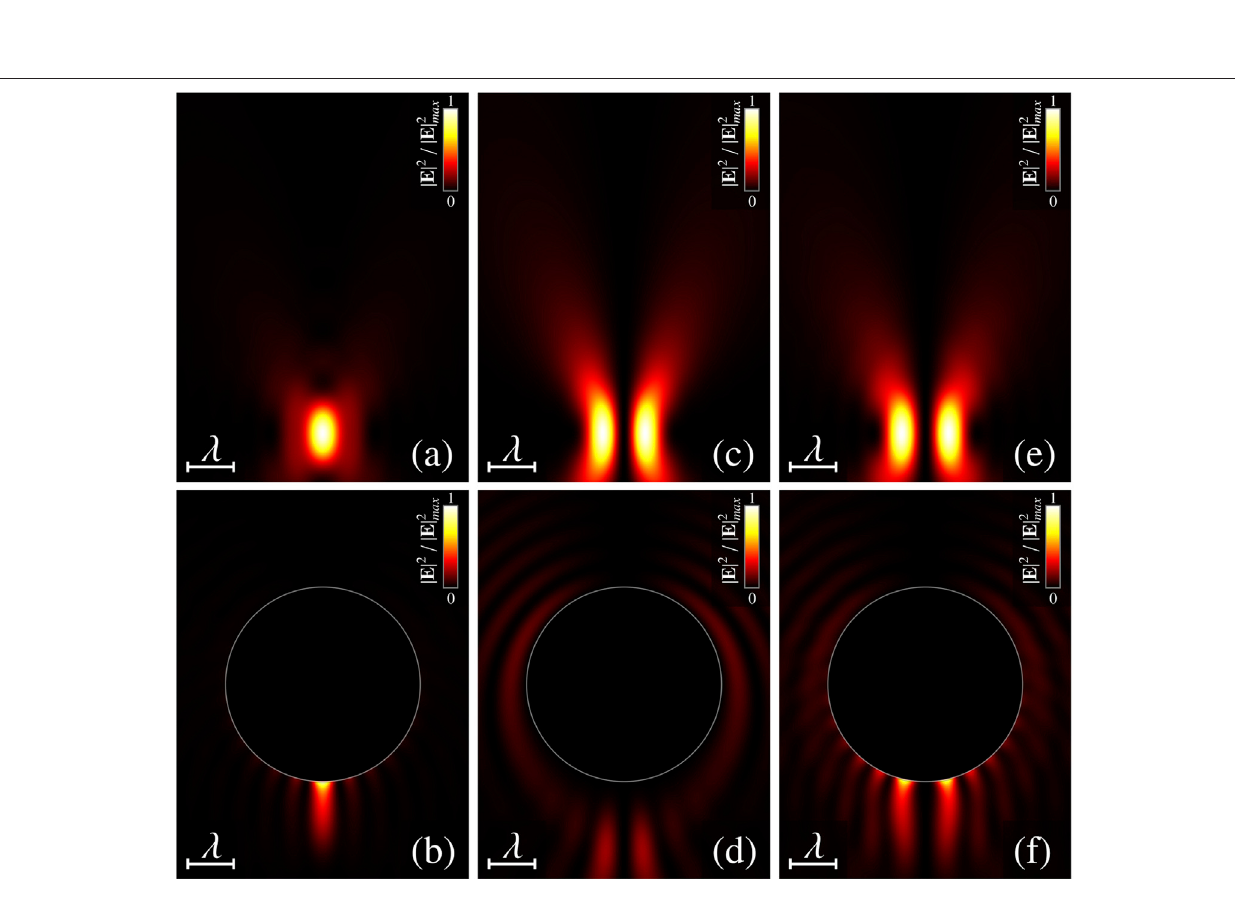
Frontiers in Physics |